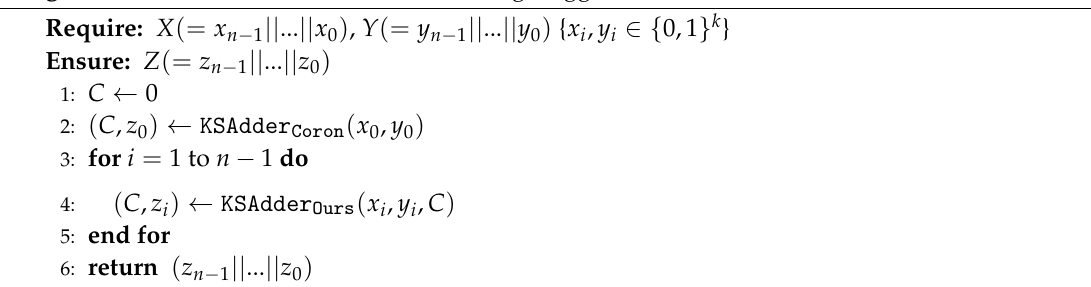
Algorithm 4: Our Multi-bit Adder Combining Kogge–Stone